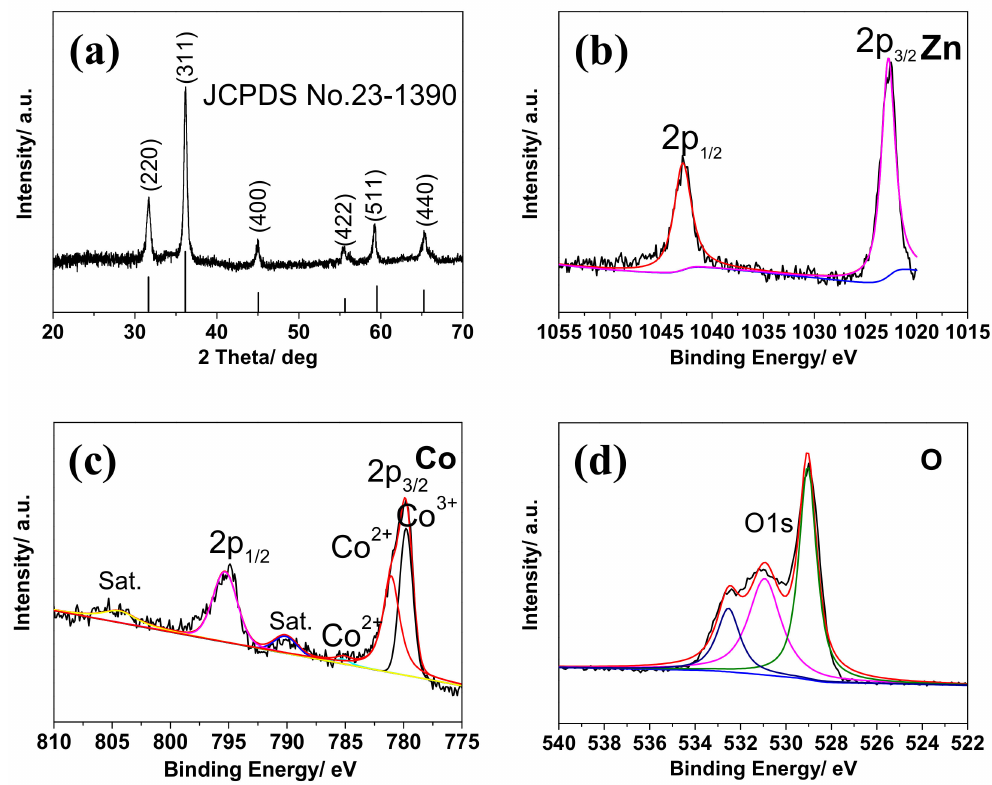
Figure 1. ( a ) XRD patterns of the ZnCo 2 O 4 nanosheets; ( b – d ) XPS results of the ZnCo 2 O 4